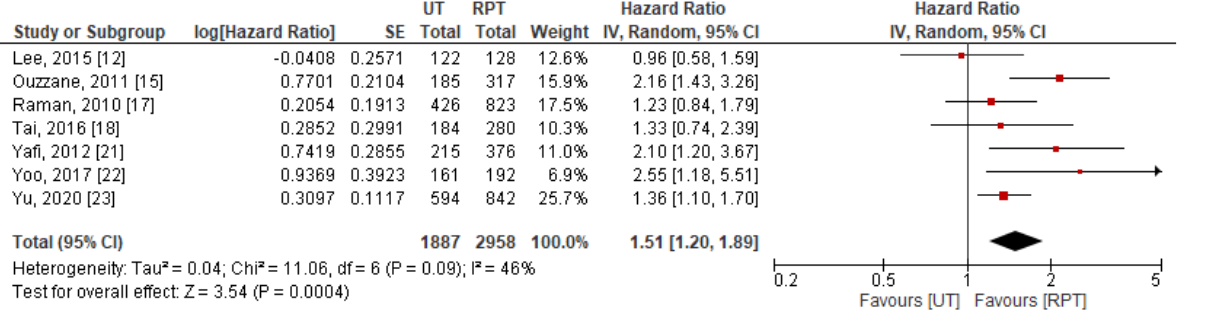
Figure 5. Forest plot and meta-analysis of disease-free survival [12,15,17,18,21–23]. CI = confidence interval; IV = inverse variance; RPT = renal pelvic tumor; SE = standard error; UT = ureteral tumor.